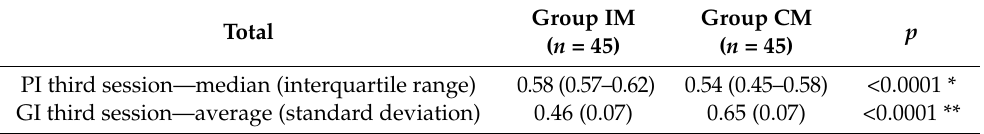
Table 13. Average of PI and GI in the third monitoring session in male patients. Male PI third session—median (interquartile range) 0.58 (0.58–0.62) 0.0033 *